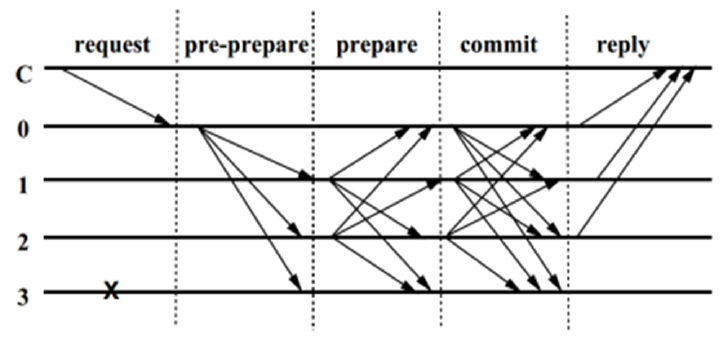
Figure 5. Execution process of the PBFT algorithm.